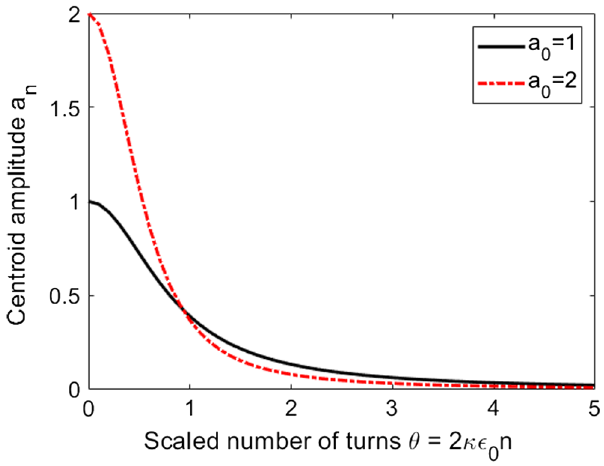
ffiffiffiffiffi p ε ) versus 0 1 and a 2 of the 0 ¼ 0 ¼